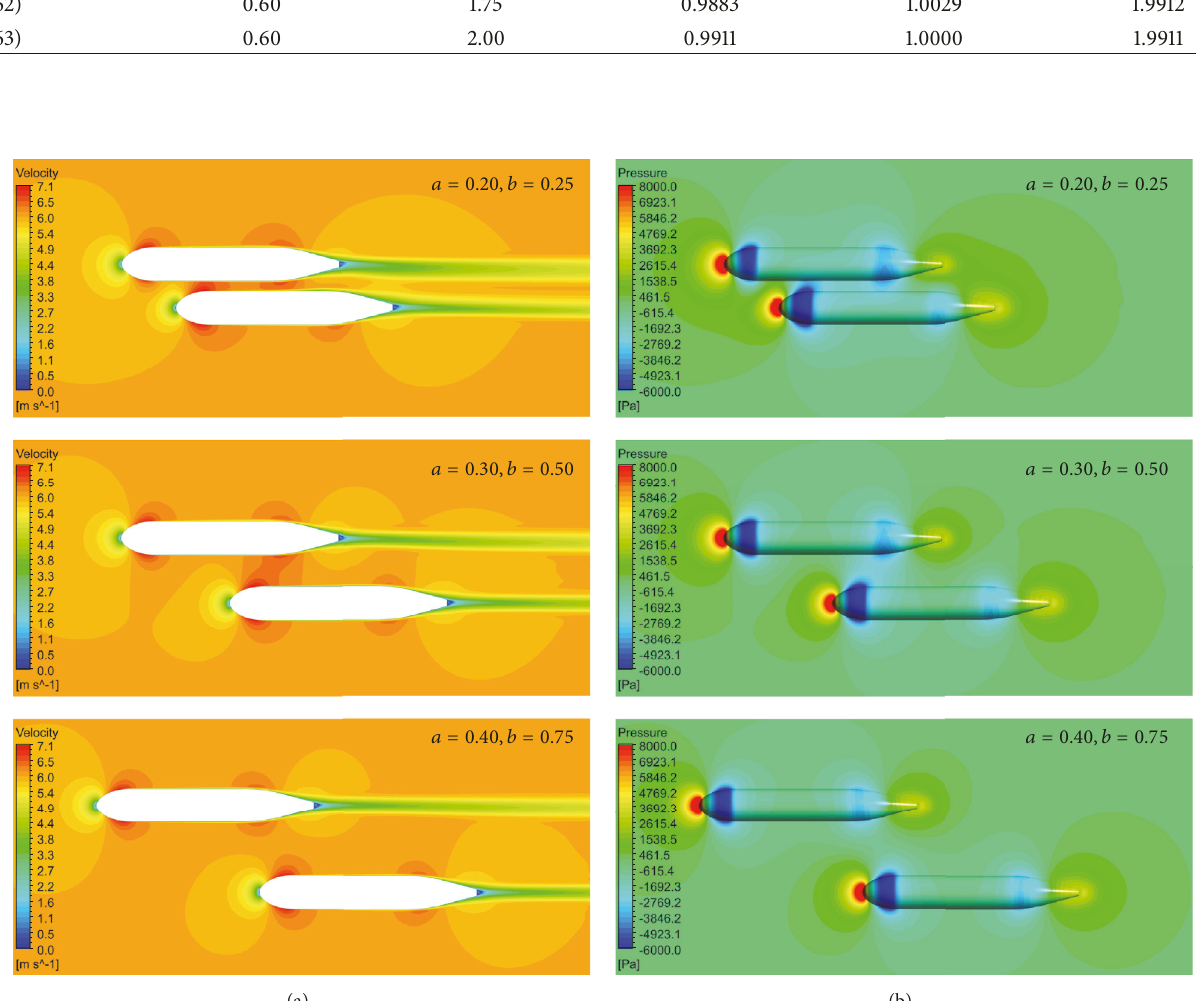
Figure 13: Contours of (a) velocity and (b) pressure around two AUVs in the Pull